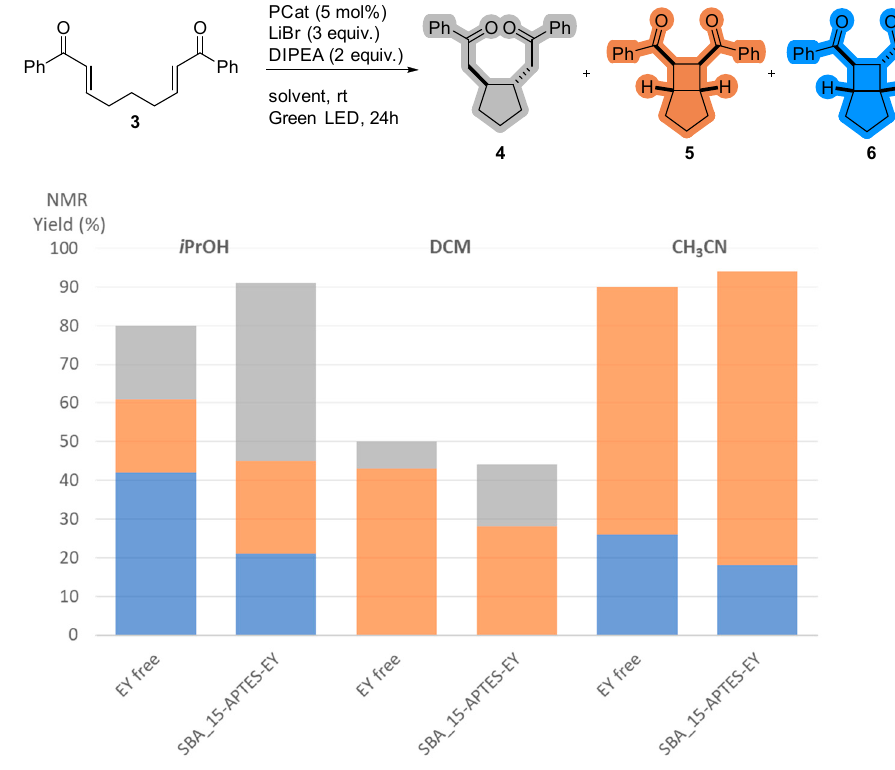
Figure 2. Influence of solvent on photoreductive cyclization of 3 .